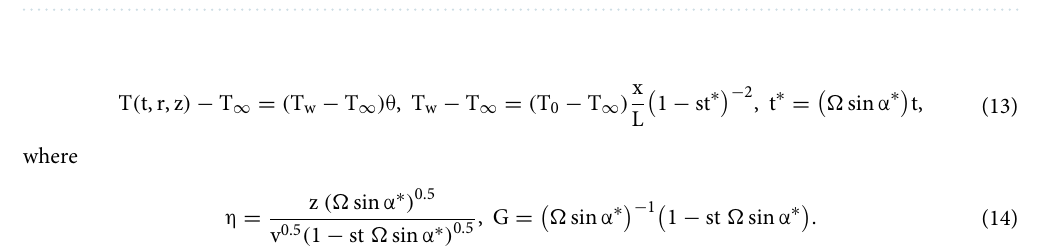
Table 2. Mesh statistics